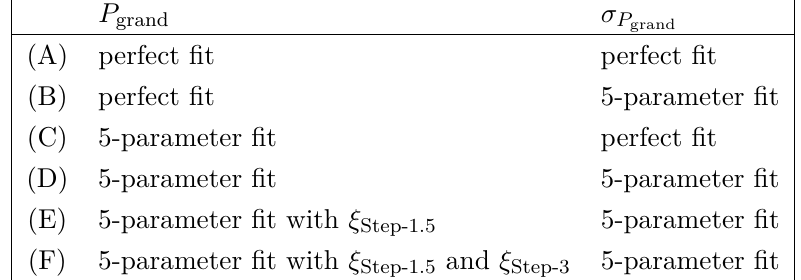
Table 1 . (A) to (F) is the category of the normalized grand power excess with different P grand and σ grand depending mainly on the background parametrizations.